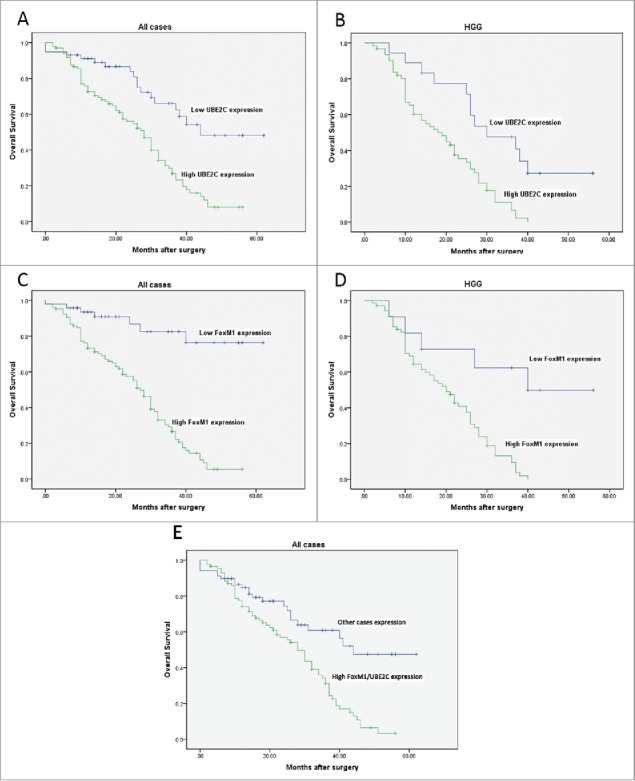
Kaplan–Meier curves for overall survival with gliomas. (A-B) Kaplan–Meier curves for OS in patients with gliomas divided according to UBE2C expression levels among all cases and high-grade gliomas (WHO grades III and IV). (C-D) Kaplan–Meier curves for OS in patients with gliomas divided according to FoxM1 expression levels among all cases and high-grade gliomas. (E) Kaplan–Meier curves for the OS of patients with gliomas with high FoxM1/UBE2C expression levels and of other patients.